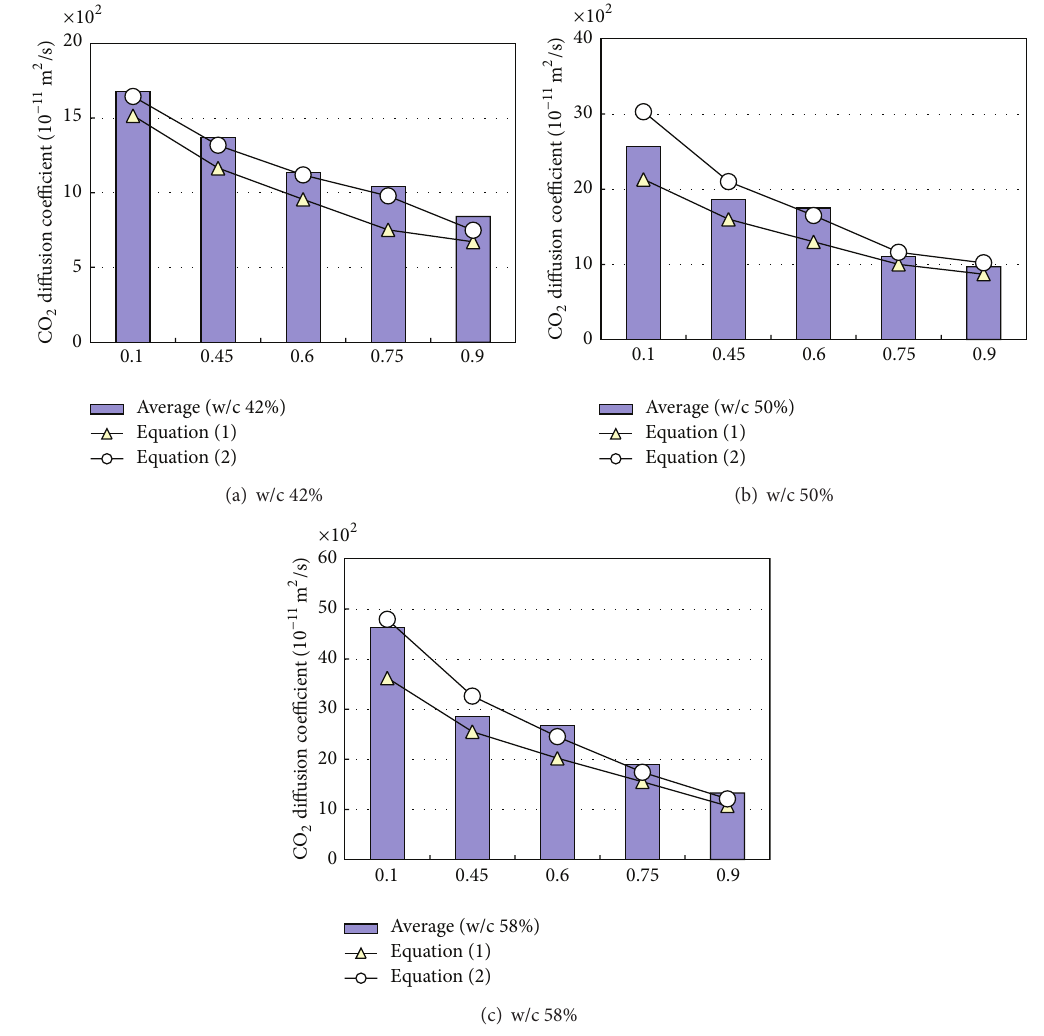
Figure 4: Test and simulated results for diffusion coefficient. Table 6: Variables and constants in regression